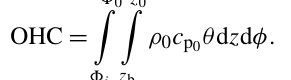
Figure 1. Estimation of mean AMET and each component in each month at 60 ◦ N with ERA-Interim from 1979 to